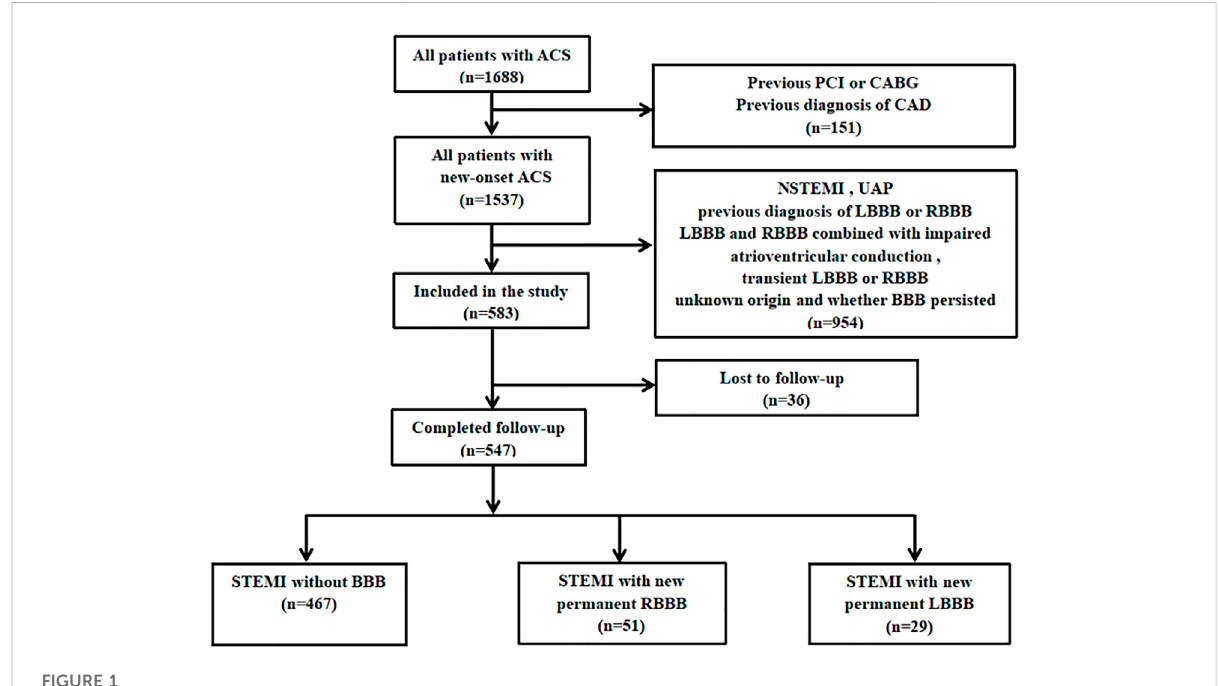
FIGURE 1 Flowchart of patient